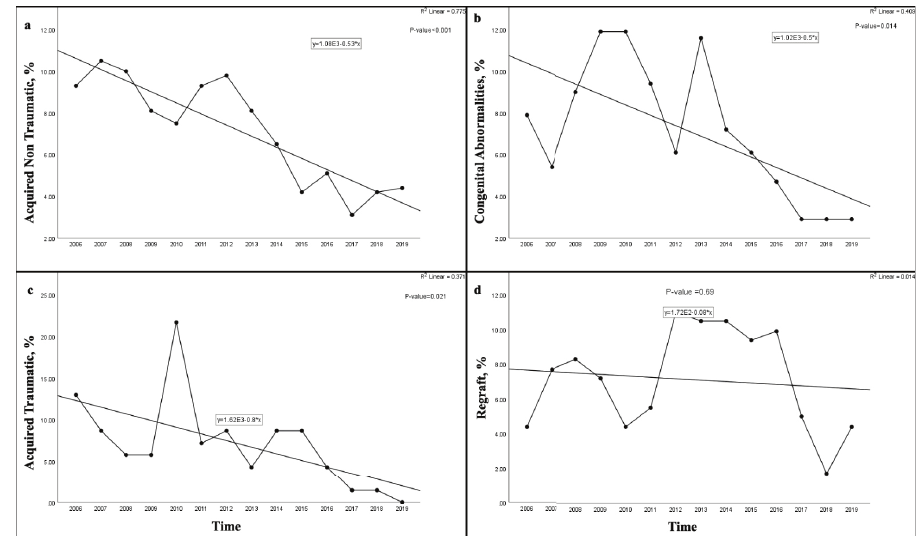
Figure 1. Trends of indications for pediatric keratoplasty between 2006 and 2019. Note the significant falling trend for acquired non-traumatic diseases (a; P < 0.001); congenital abnormalities (b; P = 0.014), and acquired traumatic diseases (c; P = 0.021). No significant change of trend is observed for the regraft over the 14-year period (d; P =